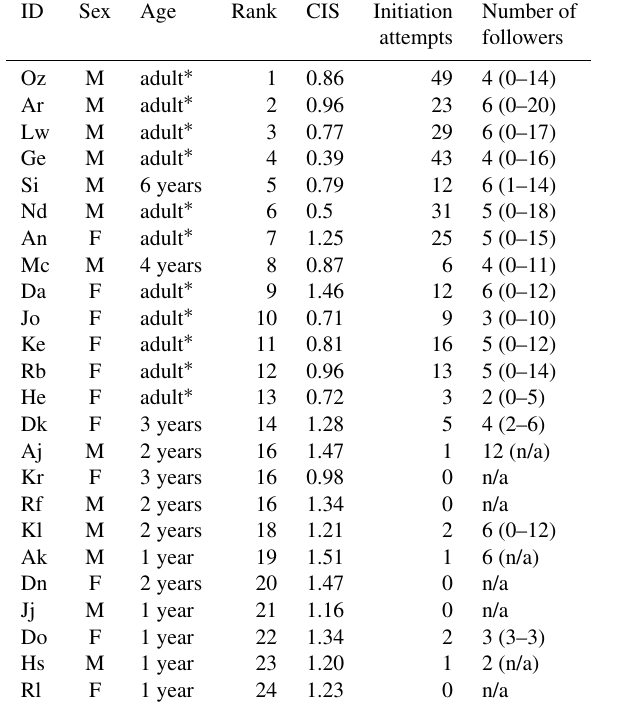
Table 1. Composition of the study group including information on age class, ordinal dominance rank, social integration, number of initiation movements and mean (range) number of